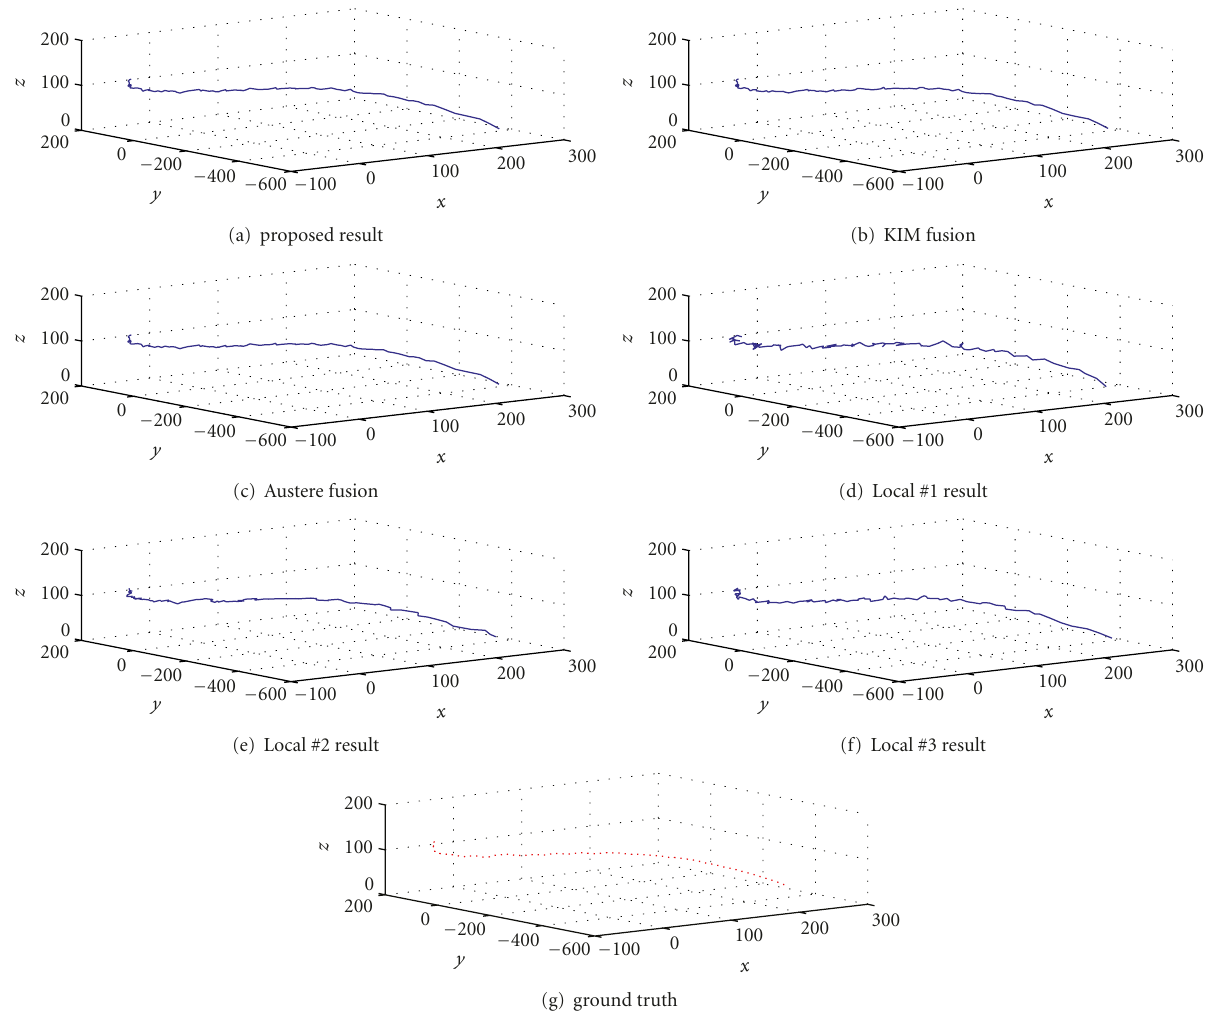
Figure 8: 3D tracking results for sequence 2. (a) Global estimate (b) Kim’s fusion (c) Austere’s fusion (d)–(f) local estimates (g) Ground